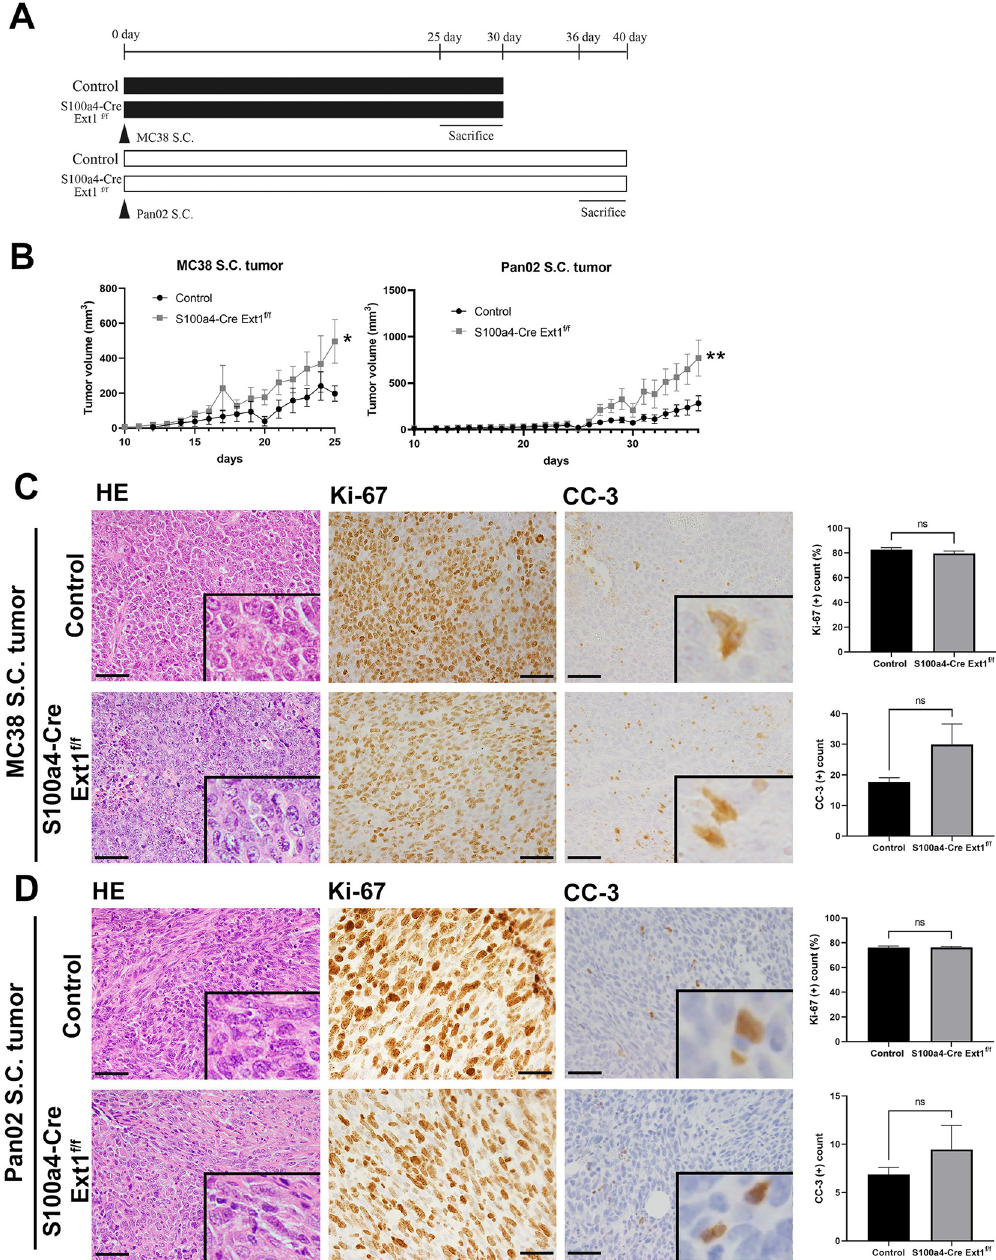
Fig 2. S100a4-Cre; Ext1 f/f mice enhanced tumor growth in subcutaneous engrafted colon and pancreatic cancer cells. (A) Experimental design of the subcutaneous tumor model. (B) The change of MC38 and Pan02 S.C. tumor volume in S100a4-Cre; Ext1 f/f and control mice. Each data point represents the mean tumor volume ± SEM. (MC38 S.C. tumor— control, N = 10, S100a4-Cre; Ext1 f/f , N = 16; Pan02 S.C. tumor—control, N = 12, S100a4-Cre; Ext1 f/f , N = 9; Mann–Whitney test, � P < 0.05, �� P < 0.01). (C) Representative H&E staining of subcutaneous tumors and immunostaining of Ki-67 and cleaved caspase-3 (CC-3) of MC38 S.C. colon tumors in S100a4-Cre; Ext1 f/f and control mice (left). The ratio of Ki-67 and the number of CC-3-positive cells in tumors of S100a4-Cre; Ext1 f/f and control mice (right). Ki-67 data represent mean ± SEM, and CC-3 data represent mean ± SEM (N = 6 for each cohort, for both). Scale bar = 50 μ m. (D) Representative H&E staining of subcutaneous tumors and immunostaining of Ki-67 and cleaved caspase-3 (CC-3) of Pan02 S.C. pancreatic tumors in S100a4-Cre; Ext1 f/f and control mice (left). The ratio of Ki-67 and the number of CC-3-positive cells in tumors of S100a4-Cre; Ext1 f/f and control mice (right). Ki-67 data represent mean ± SEM, and CC-3 data represent mean ± SEM (N = 6 for each cohort). Scale bar = 50 μ m.